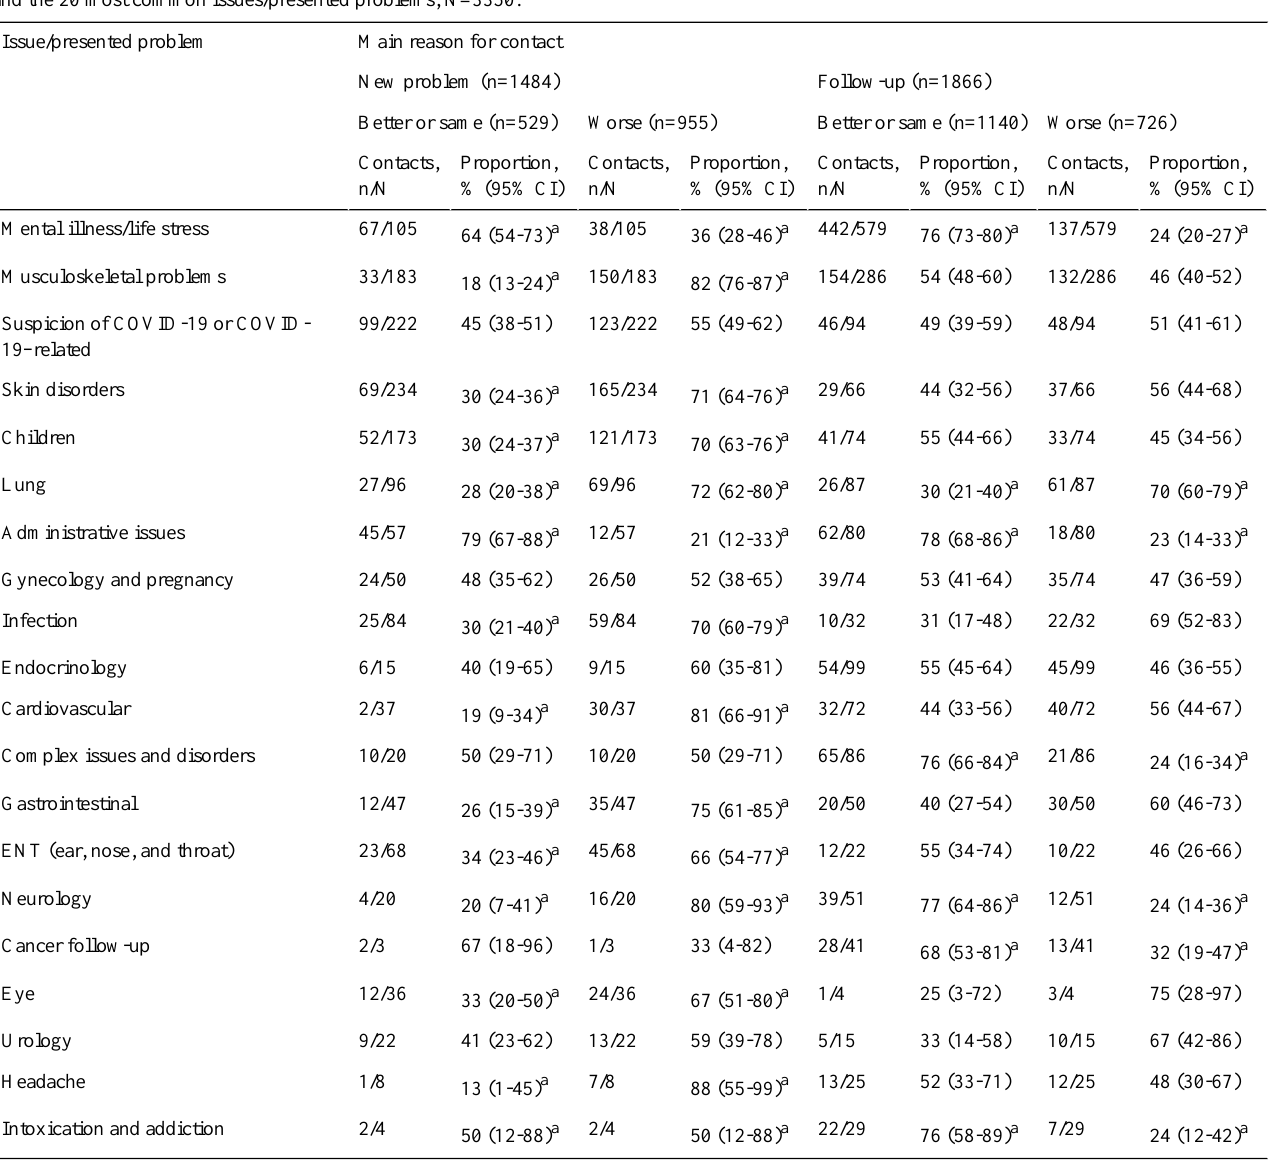
Table 4. Suitability of video consultations compared to face-to-face consultations, association with main reason for contact (new problem/follow up), and the 20 most common issues/presented problems,